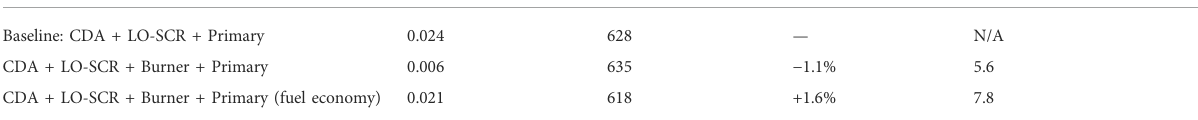
TABLE8LLCresultscomparisonbetweenBaselineandCDA+LO-SCR+Burner+Primarysystem.Thetablealsoincludesapointwithafueleconomy engine calibration. System con fi